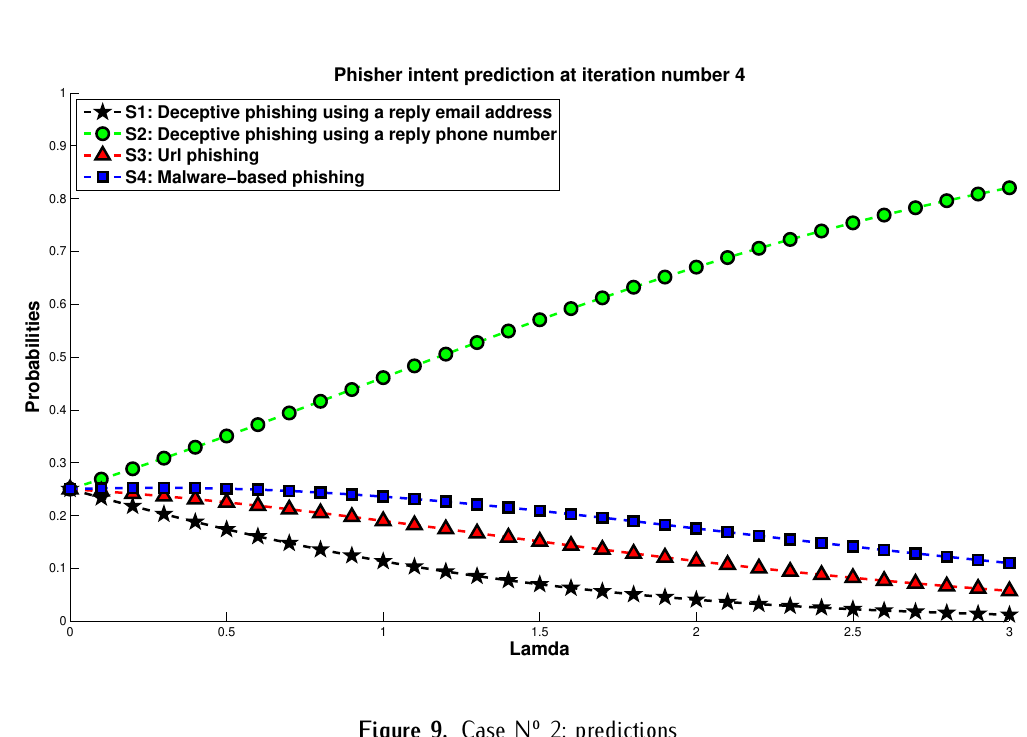
Figure 7. Case N o 1: predictions